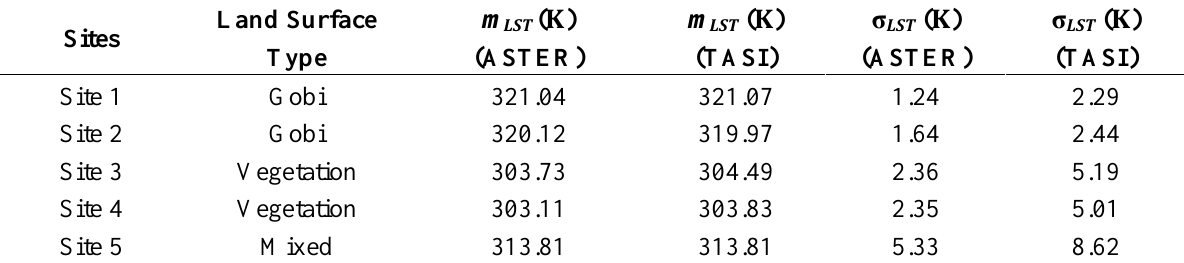
Figure 1. Spatial distribution and ground photographs of the five study sites. The upper right image is the ASTER L1 B VNIR image of the study area taken on 10 July 2012. The RGB components are channels 3 (0.81 μm ), 2 (0.66 μm ) and 1 (0.56 μm ), and the spatial resolution is 15 m. The land cover types include ( a ) cropland, ( b ) Gobi, ( c ) river and ( d ) village. Table 2. The main types of land surface cover and the mean values and standard deviations of LST in the five study areas. m and σ represent the mean and standard deviation, LST LST respectively, and were calculated from both the ASTER and TASI LST